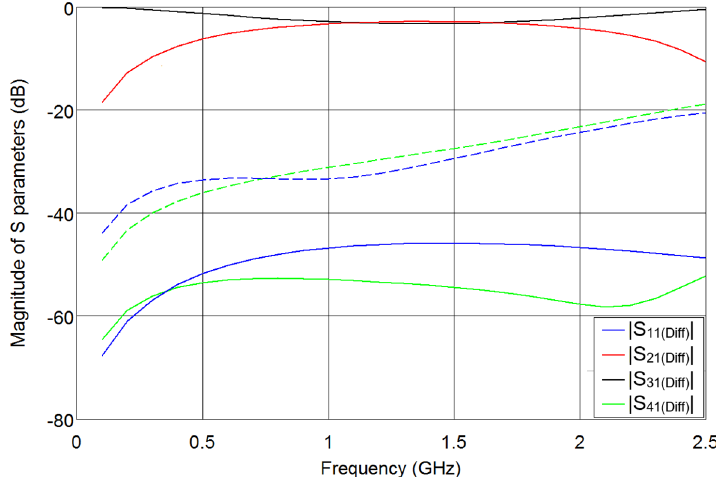
Figure 4. Electromagnetically calculated differential S ‐ parameters of the four strip coupled ‐ line section operating in a differential mode: the compensated section is represented by solid lines and uncompensated one by dashed lines.